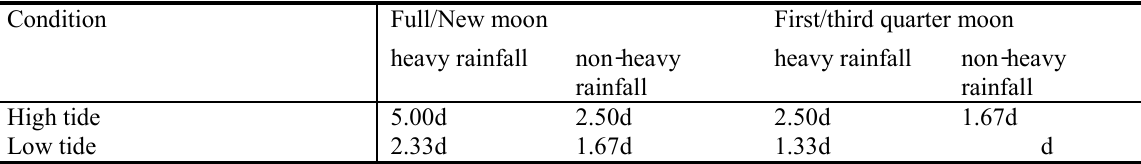
River depth at high and low tide, rainy and non-rainy, full/new moon and first/third quarter moon.